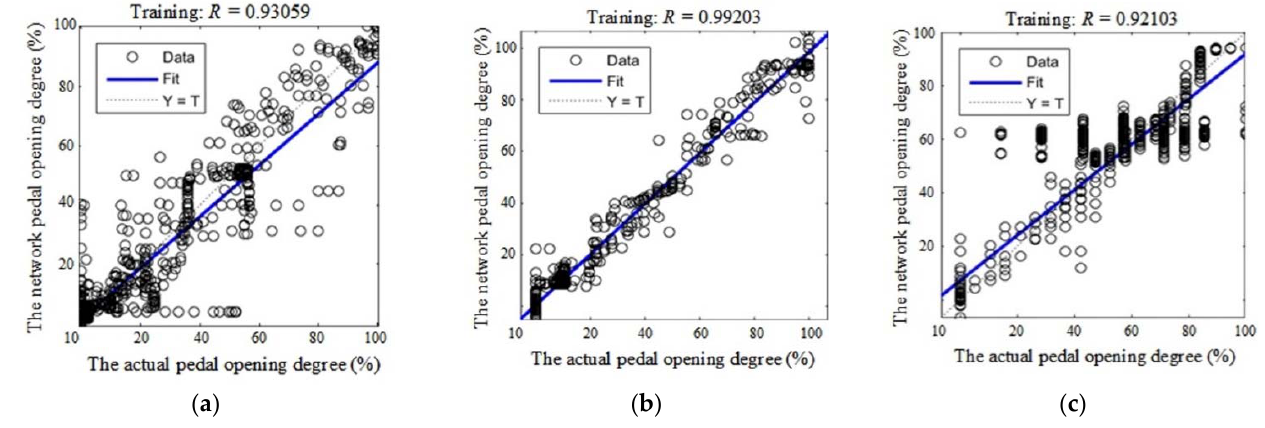
Figure 13. The training results for the linear neural network: ( a ) the result for aggressive driving type; ( b ) the result for general driving type; ( c ) the result for steady driving type.